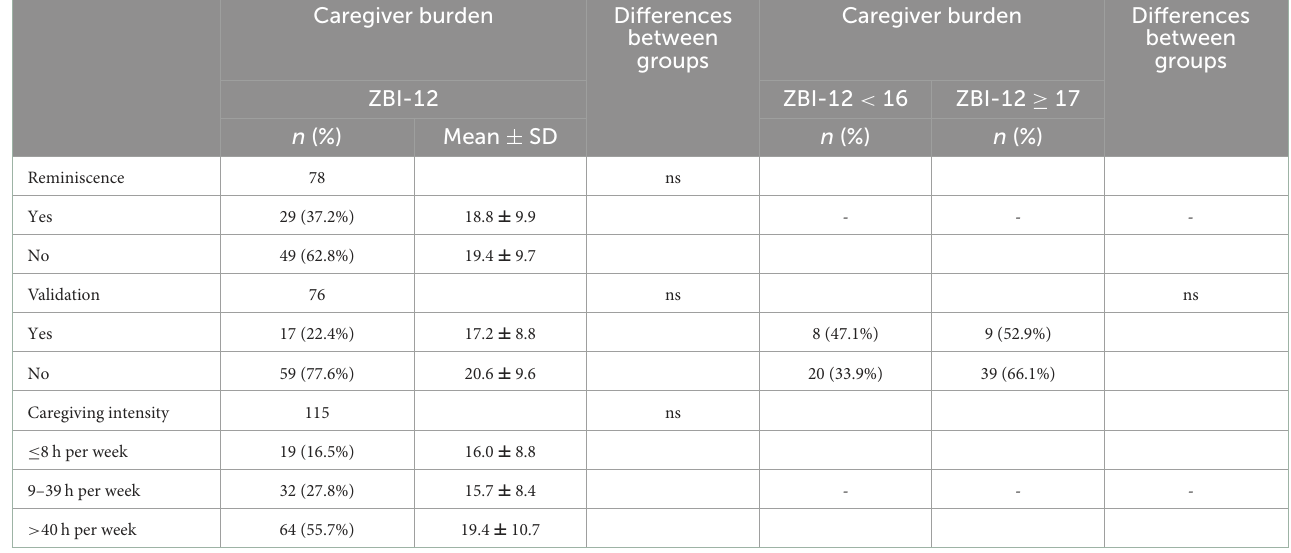
TABLE 4 Associations between subjective caregiver burden with applying therapeutic communication methods ( t -tests, Chi-square), and with objective caregiver burden (One-way ANOVA). Caregiver burden Differences Caregiver burden Differences between between groups